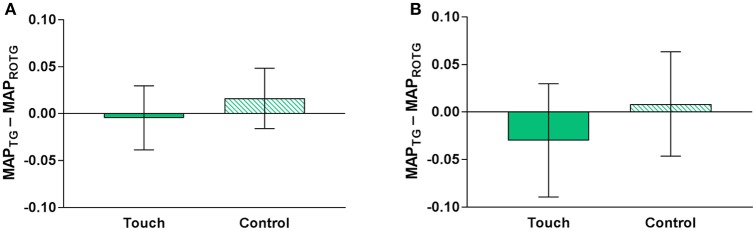
Betrayal aversion (MAPTG-MAPROTG) in the touch and control conditions, (A) within subjects and (B) between subjects in the first round of the Betrayal Aversion Elicitation Task. Error bars represent 95% confidence intervals.